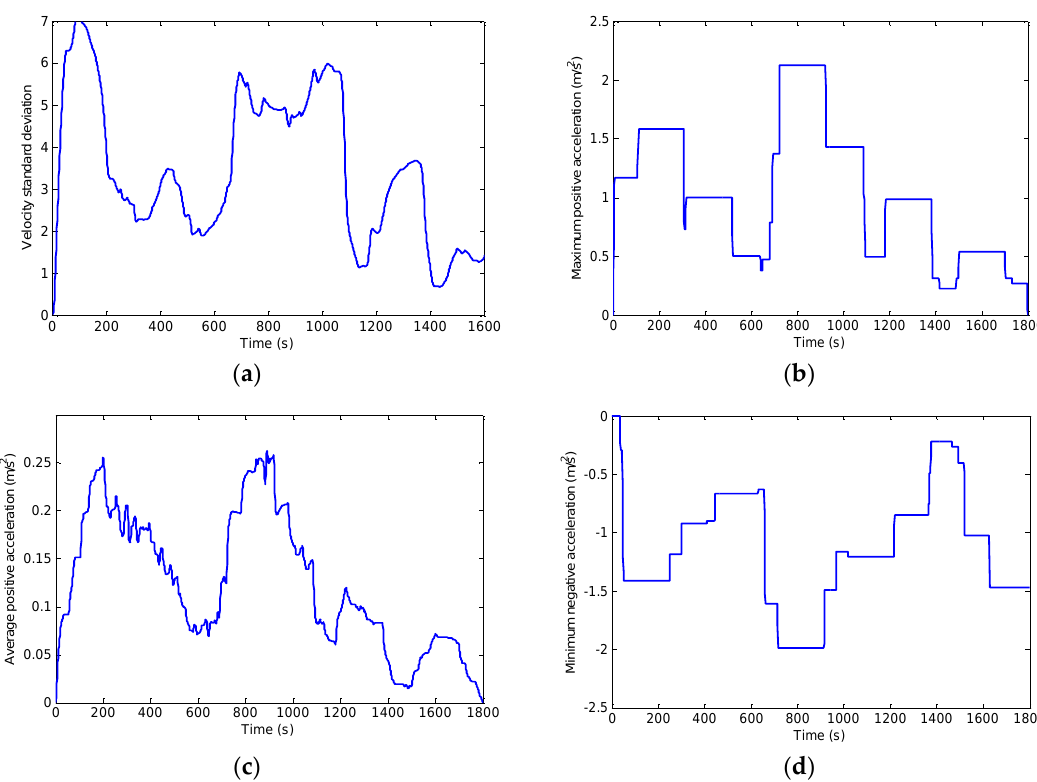
Figure 15. Characteristic parameters extracted from highway driving cycle. ( a ) Velocity standard deviation; ( b ) Maximum positive acceleration; ( c ) Average positive acceleration; ( d ) Minimum negative acceleration.